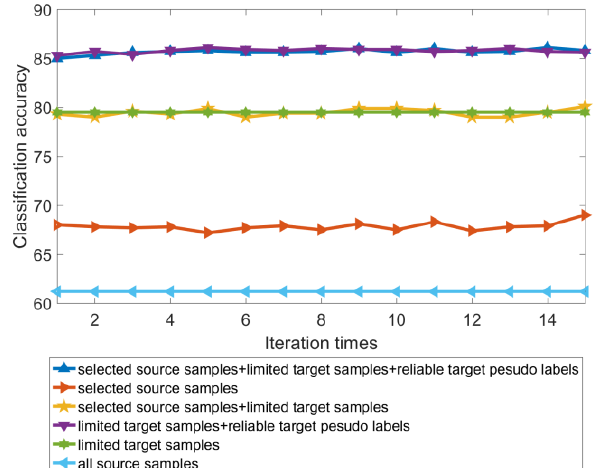
Figure 17. The experimental results of ResNet-101 architecture with 10% training ratio.